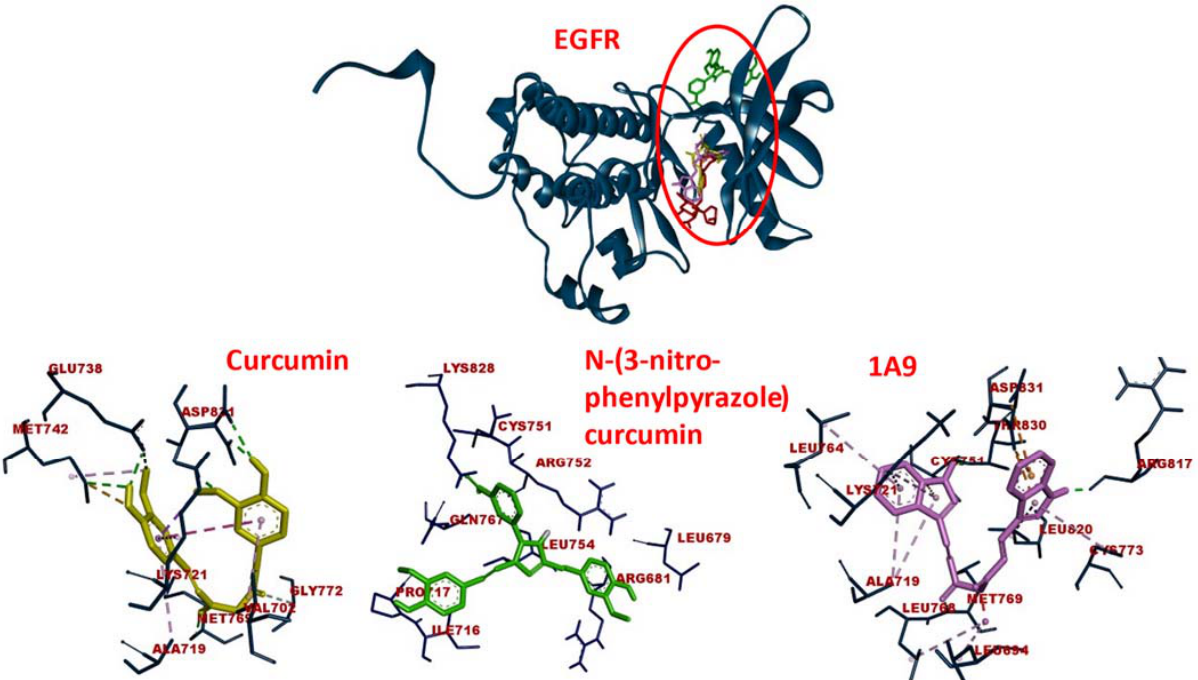
Figure 1. Molecular docking of curcumin ‐ type compounds to EGFR. Top: The compounds were bound to the same domain of EGFR. Bottom: curcumin, N ‐ (3 ‐ nitrophenylpyrazole) curcumin, and the derivative 1A9 were bound to different amino acids in this domain. The red circle indicates the binding site of the three compounds.